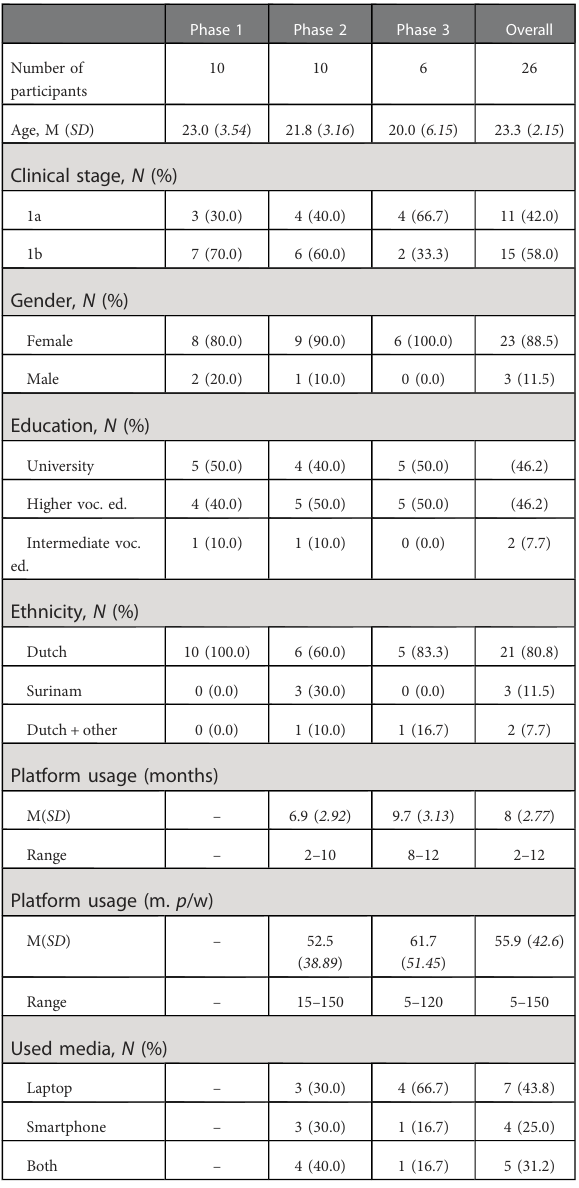
TABLE 1 Demographics per study phase and